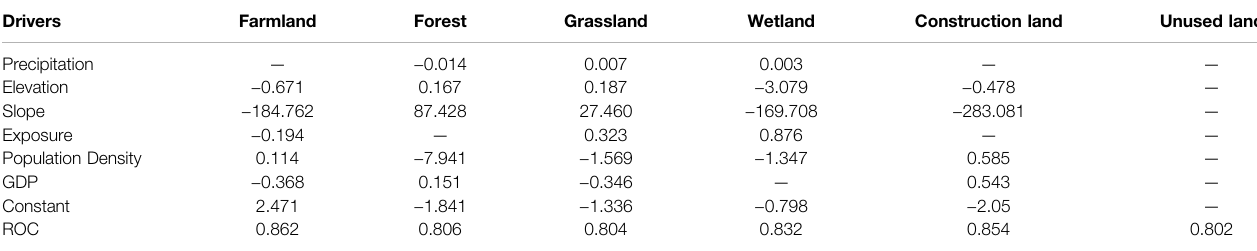
TABLE 4 | Results from the Logistic regression analysis of Sanmen Bay. Drivers Farmland Forest Grassland Wetland Construction land Unused